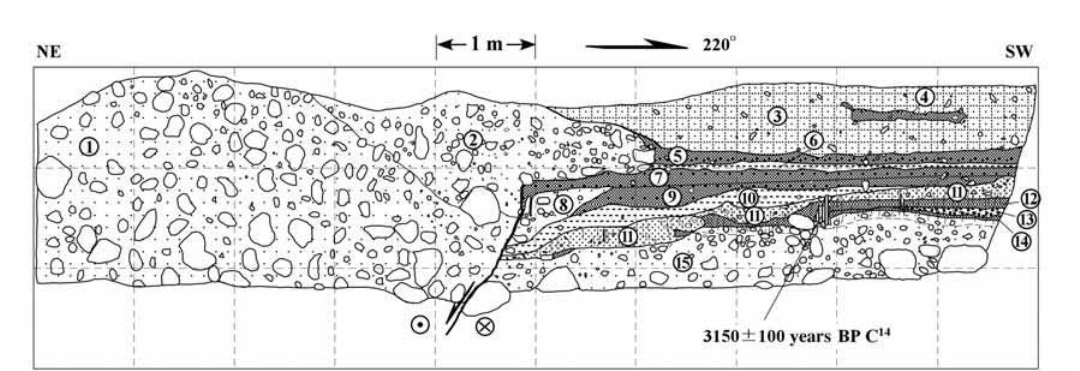
Fig. 8. Log of the southern wall of the trench excavated by us for this study. The location of the trench is shown in figs. 1 and 7b. 1 - Light yellow boulder gravel bed; 2 - mixed deposit wedge of gray soil and gravel; 3 - dark brown soil used for cone cultivation; 4 - black peat lens in unit 3; 5 - black peat bed; 6 - brown humus-rich silt bed; 7 - black peat bed; 8 - deposit wedge of sand gravel; 9 - black peat bed like unit 7, but having poor strati- fication; 10 - dark brown humus-rich silt bed, thicker than unit 6; 11 - light yellow gravel sand bed with rich pie- ces of root and root hair; 12 - black peat with rich pieces of root and root hair; 13 - yellow sand bed with rich pieces of root and root hair; 14 - dark brown humus-rich silt bed with rich pieces of root and root hair; 15 - gray gravel-bearing sand bed, its top layer has rich pieces of root and root